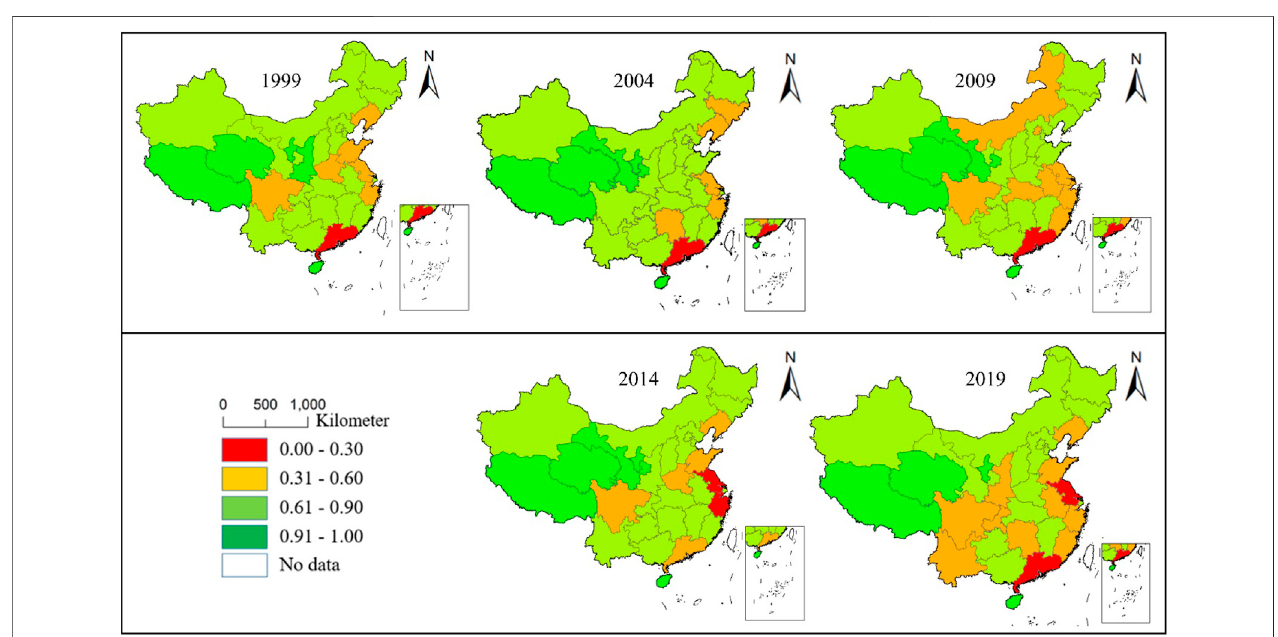
FIGURE 8 | The evolution of spatial trends in fi res in